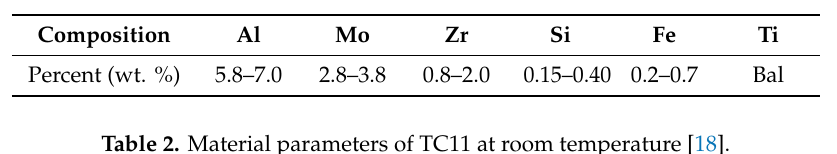
Table 1. Chemical composition of titanium alloy (TC11) [18].